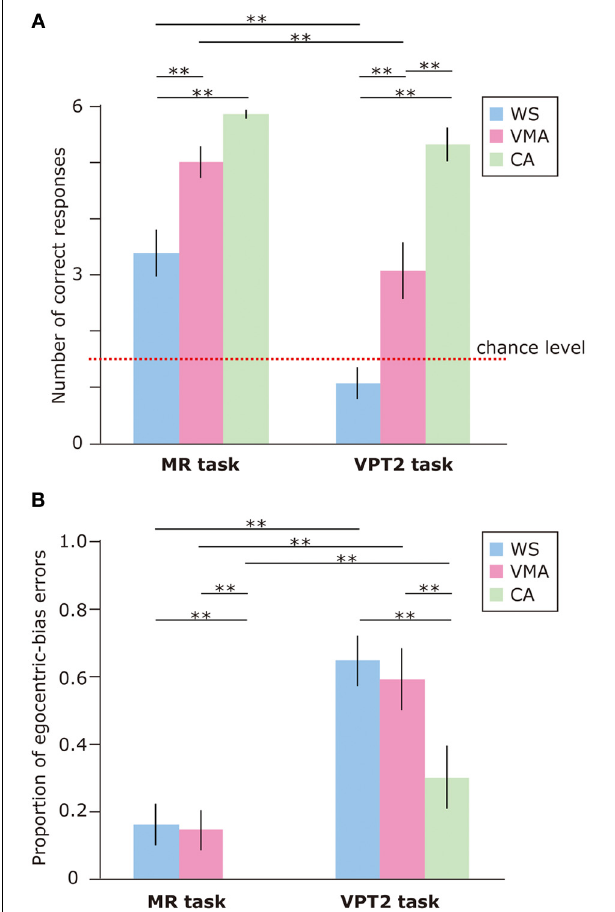
FIGURE 2 | (A) Mean number of correct trials (max: 6) in the MR and VPT2 tasks for three groups [blue: Williams syndrome (WS) group; pink: verbal mental age-matched (VMA) group; green: chronological age-matched (CA) group]. (B) Mean proportion of egocentric errors (the proportion of egocentric errors made in relation to the overall errors) for both tasks. Error bars indicate standard error. ∗∗ p < 0 .